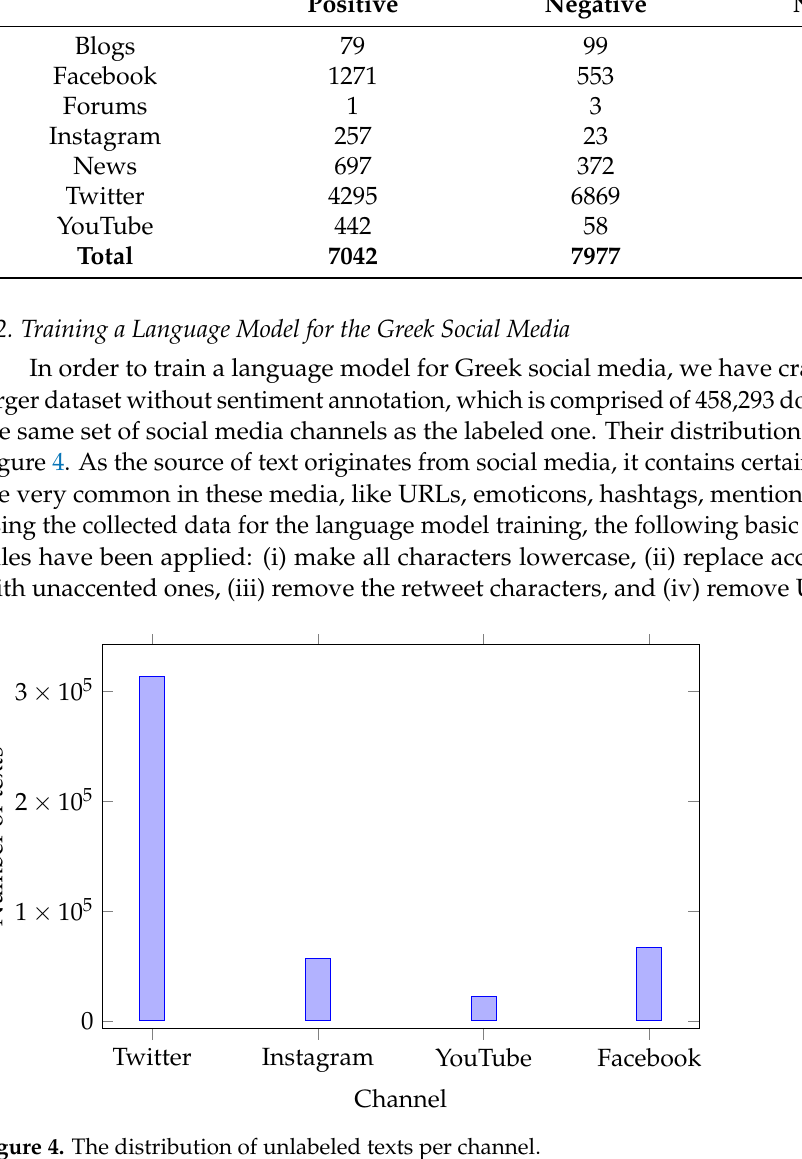
Figure 4. The distribution of unlabeled texts per